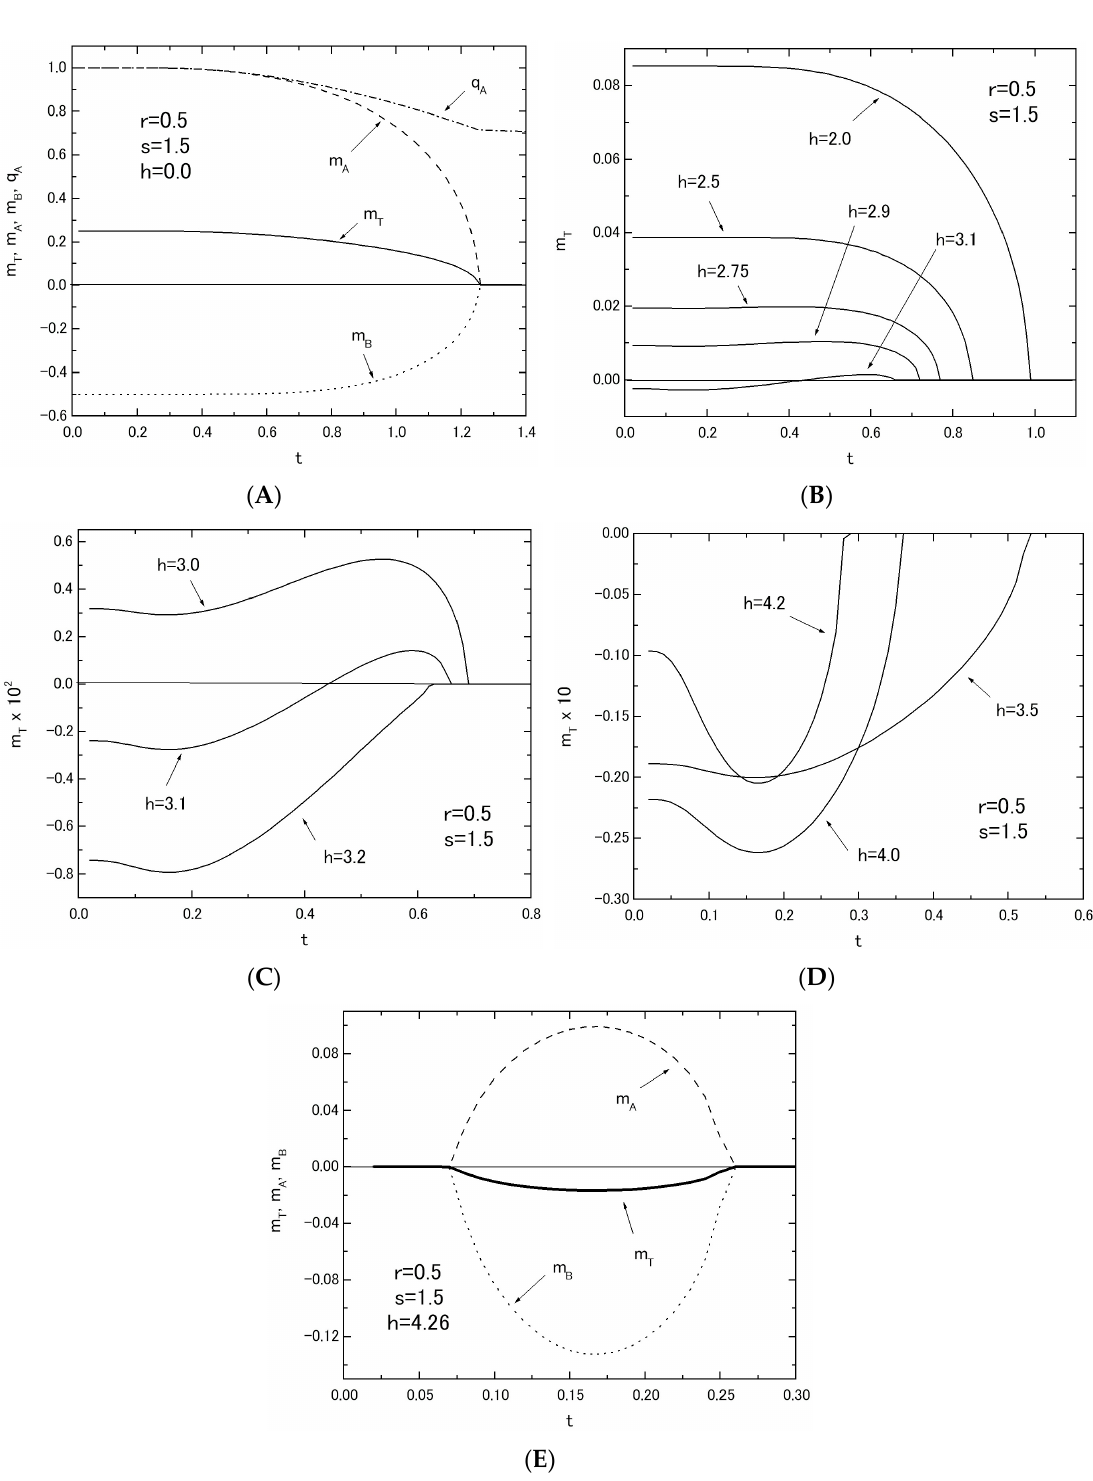
Figure 8. The temperature dependences of m T in the system B with r = 0 . 5 and s = 1 . 5; the thermal variations of m T (solid curve), m A (dashed curve), m B (dotted curve) and q A (dot-dashed curve) are depicted, when the value of h is given by h = 0 . 0 ( A ). The thermal variations of m T are given, changing the value of h from h = 2 . 0 to h = 3 . 1 ( B ). The thermal variations of m T are given by selecting the three values of h ( C , D ). The reentrant phenomena of magnetizations are presented by selecting the value of h as h = 4 . 26 ( E ) .